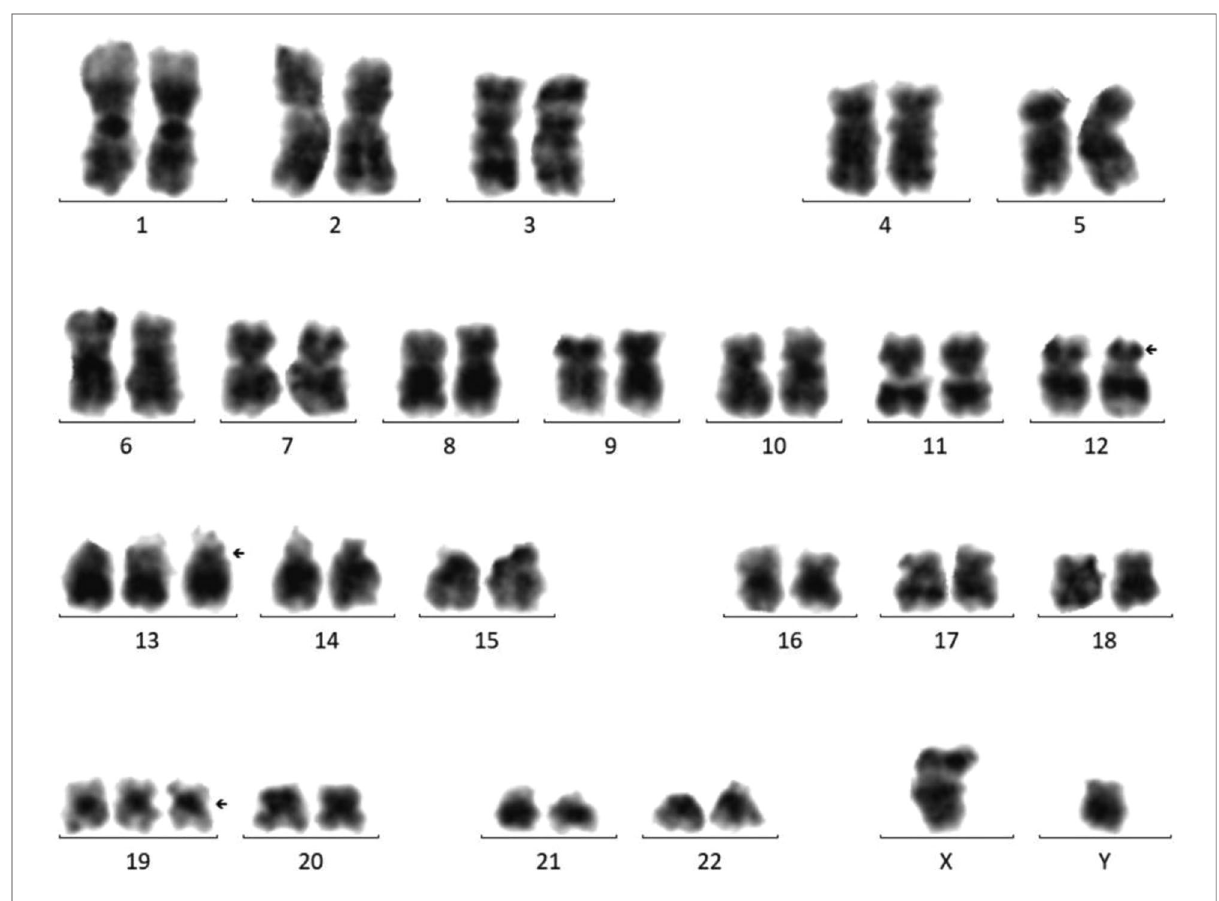
FIGURE 1 Bone marrow karyotype showing 48, XY, +13, +19[12]/48, idem, del(p12)[8].